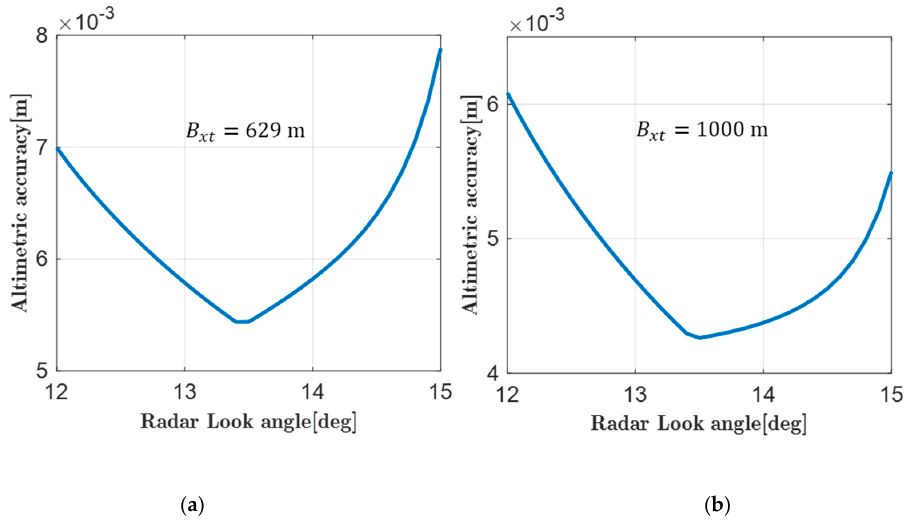
Figure 16. The absolute altimetric accuracy determined by phase noise, at 1 km resolution. ( a ) Cross-track baseline length of 629 m, and ( b ) cross-track baseline length of 1000 m.